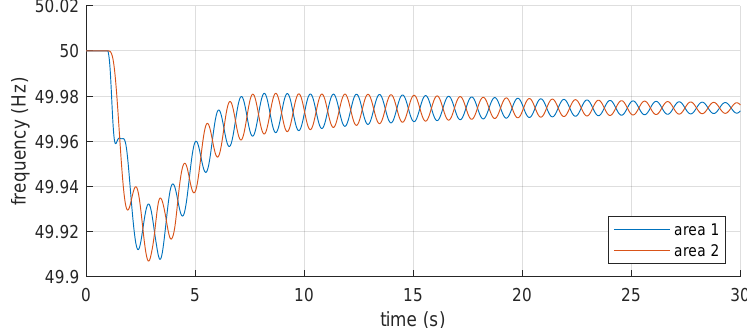
Figure 11. Grid-forming in both areas.